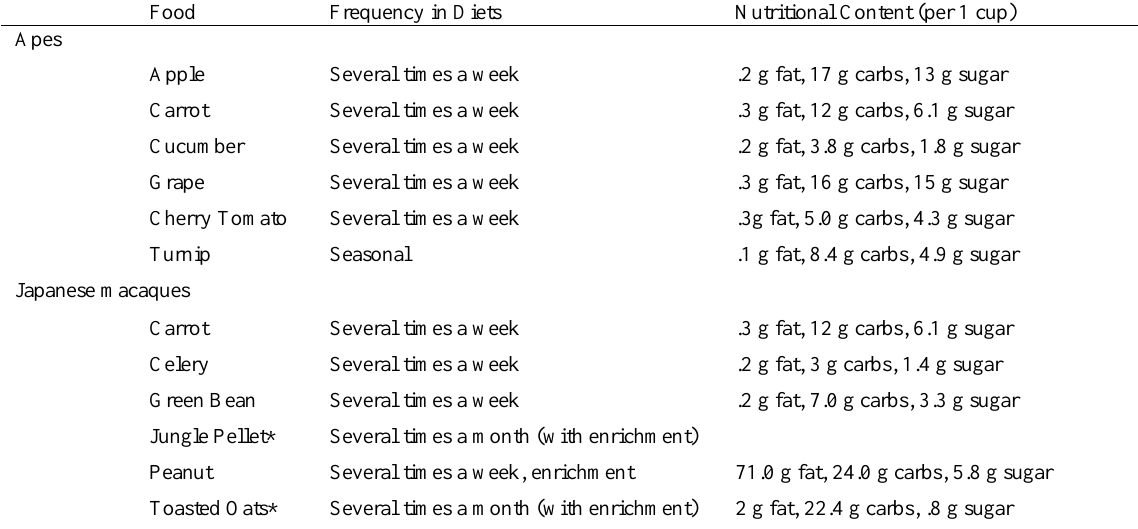
Typical Uses of each Food Item Outside of Preference Testing Food Frequency in Diets Nutritional Content (per 1 cup) Apes